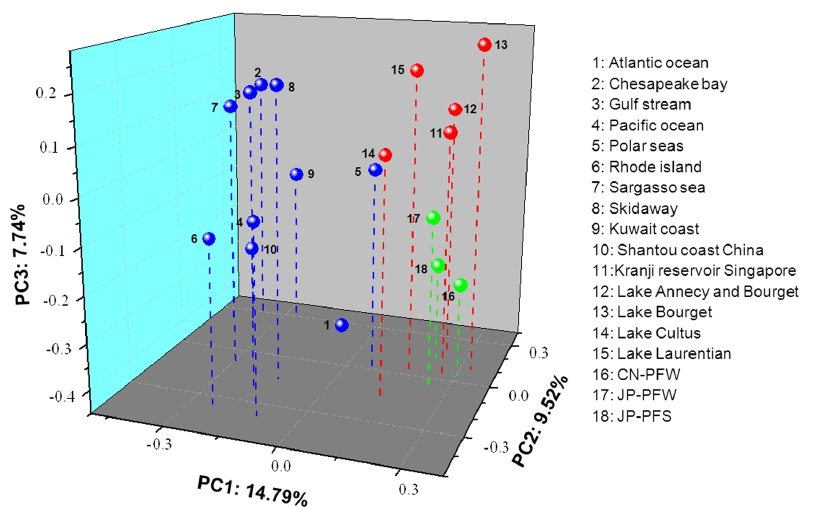
Figure 4. Three-dimensional principal coordinate analysis of g20 clone sequences of cyanophage communities obtained from marine waters ( bluecircles ), lake freshwaters ( redcircles ), and paddy fields ( greencircles ). The percentages in the axis labels represent the percentages of variation explained by the principal coordinates.